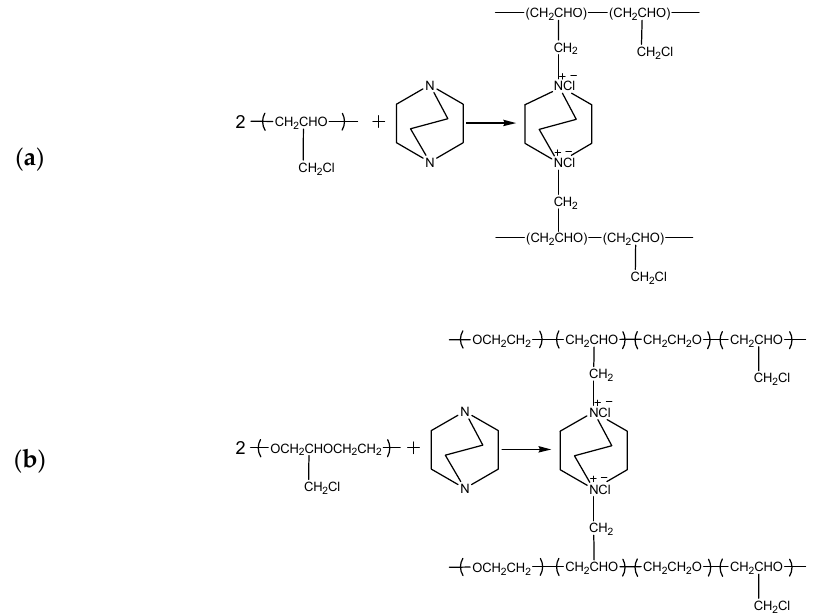
Figure 1. Reaction mechanisms of simultaneous amination and crosslinking of ( a ) PECH-H and ( b ) PECH-C type polymers.